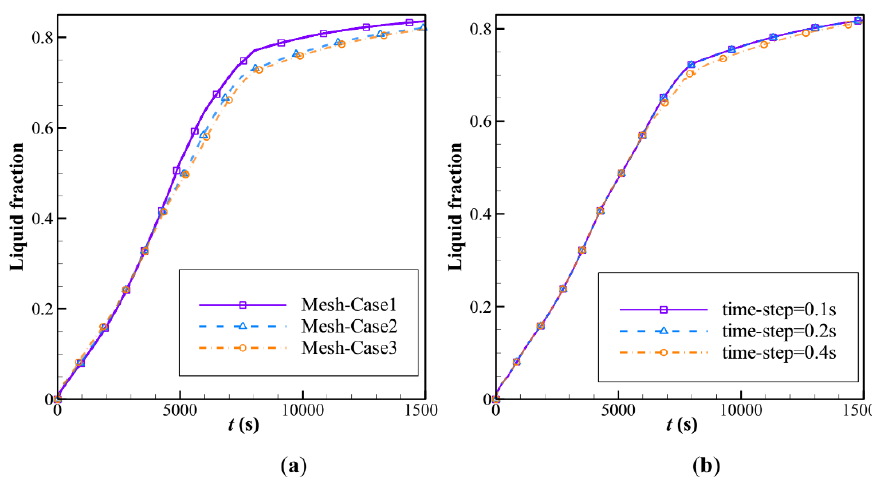
Figure 2. Influence of the mesh size and the time-step on the computed liquid fraction-melting rate (LF) for mesh-case 3 of the L16 table: ( a ) mesh size; ( b ) time-step size for mesh-case 3.